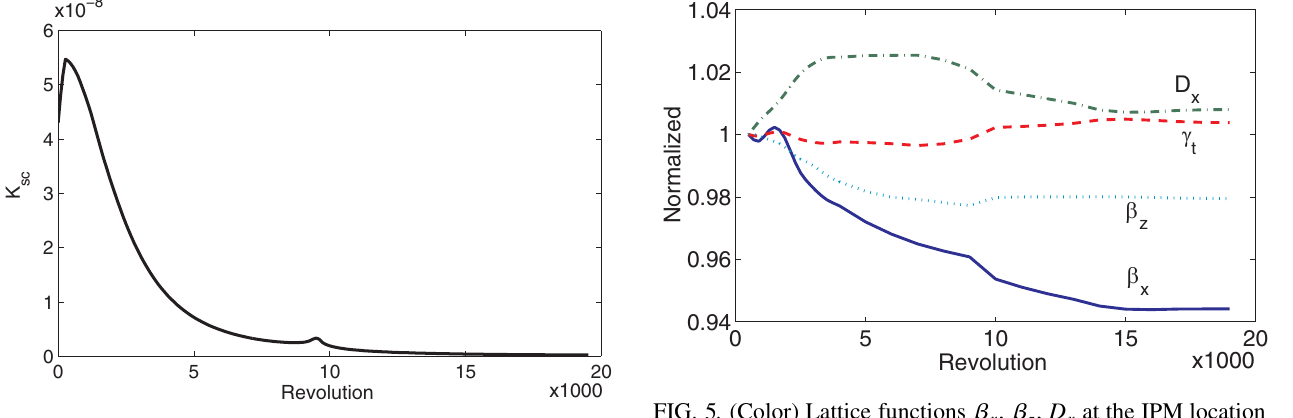
FIG. 4. The space-charge perveance parameter for an entire booster ramping cycle for the beam intensity of 10-turn injection (total charge of 4.1E12). The bunch length is derived from the total rf voltage (RFSUM) of the booster cycle while the 95% longitudinal emittance is assumed to be 0.08 eV-s.